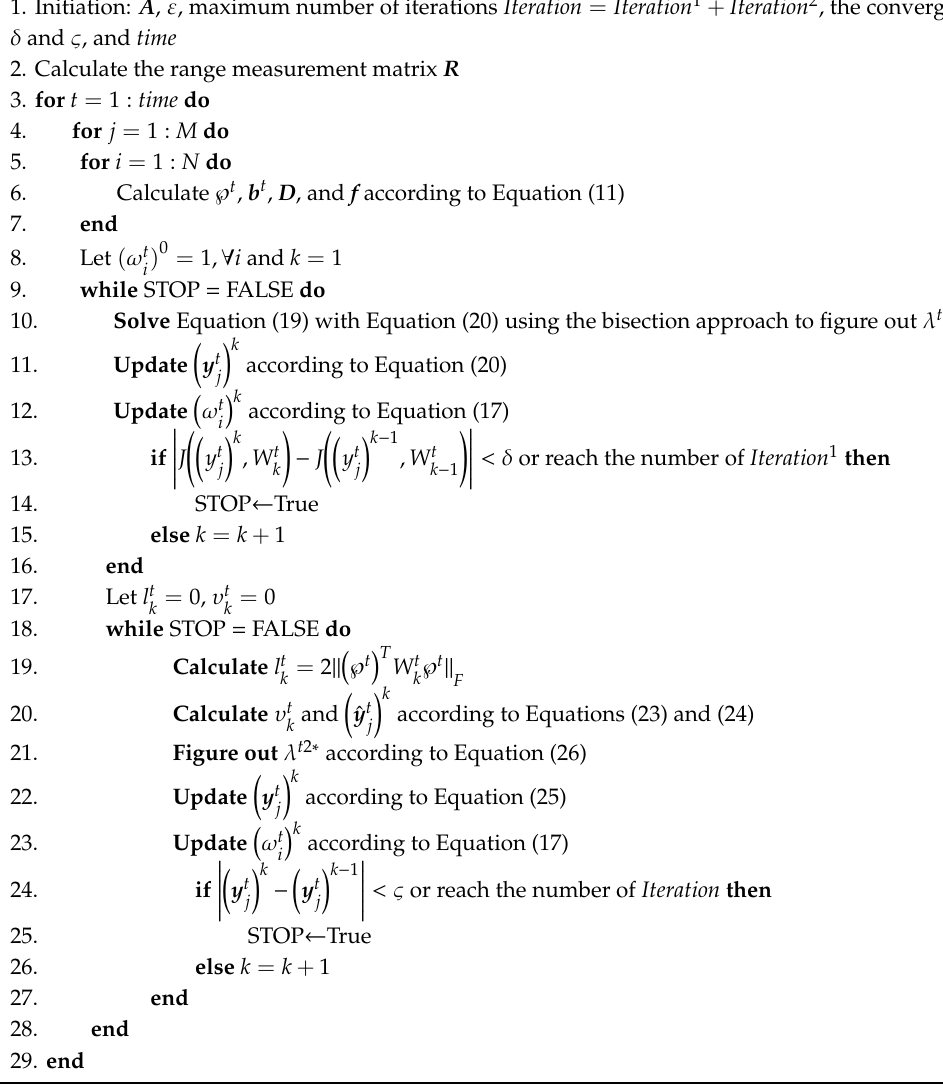
Algorithm 1. Algorithm for